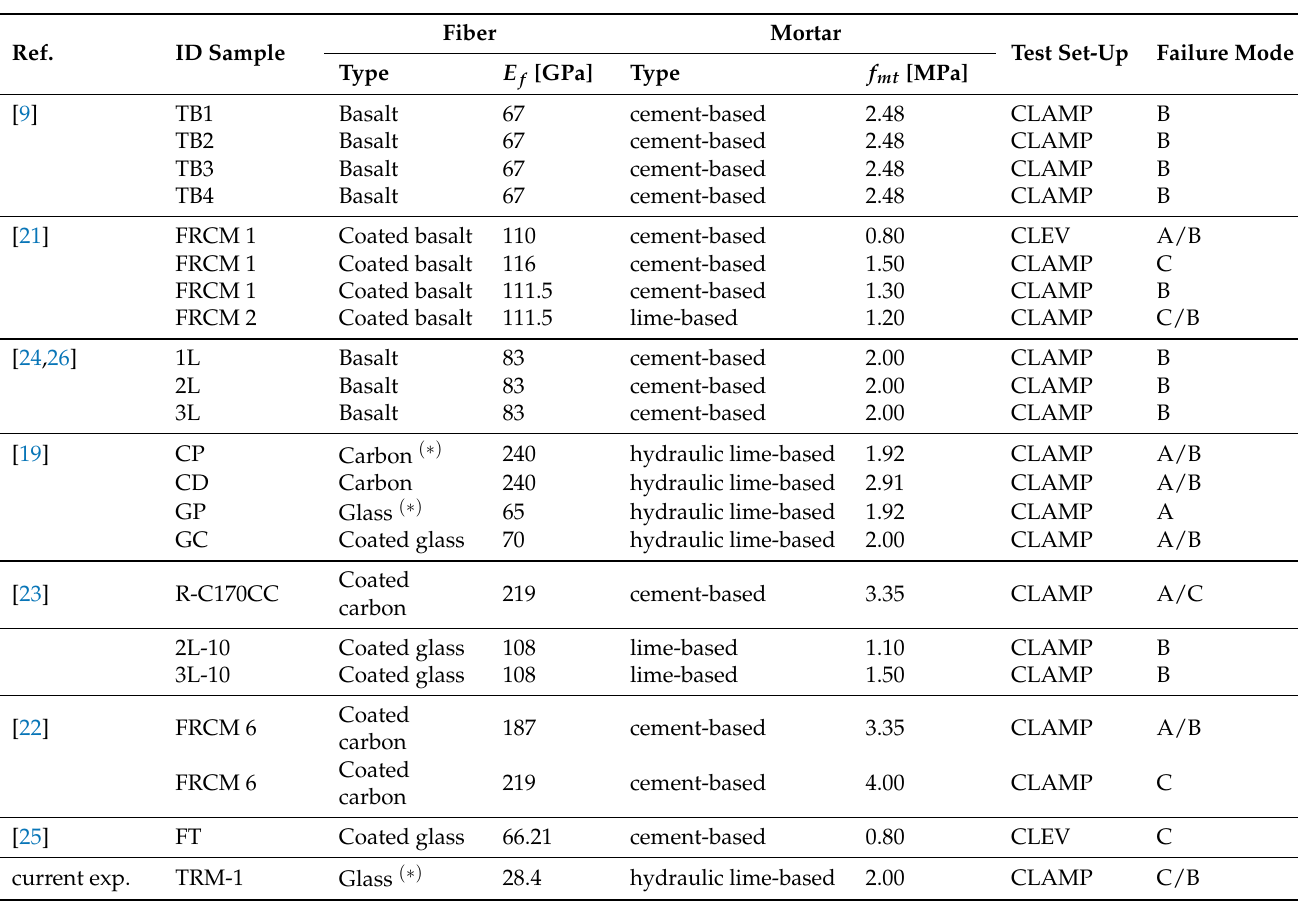
Table 3. Experimental